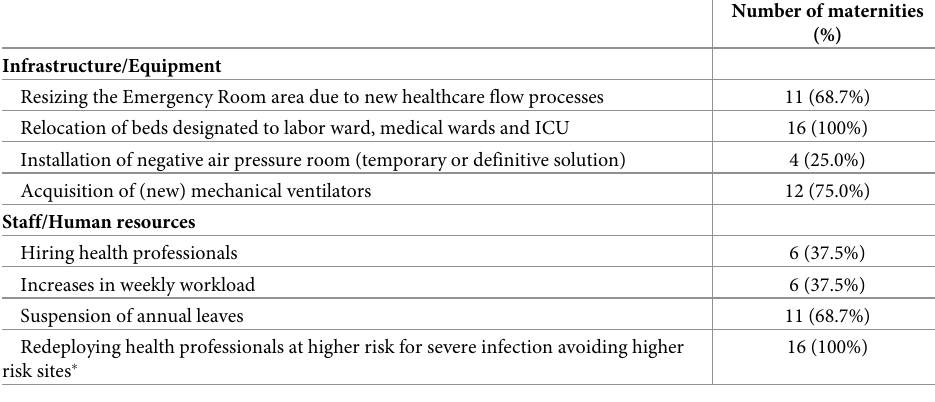
Table 2. Changes on infrastructure and human resources due to COVID-19 pandemic in the REBRACO materni- ties (n =